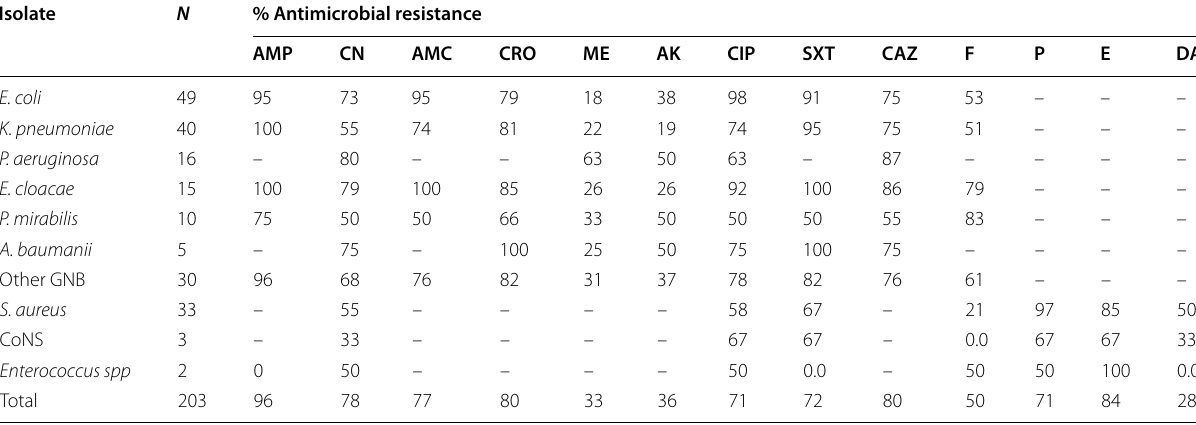
Table 1 Antimicrobial resistance pattern of bacterial pathogens causing UTI among men with prostate enlargement at